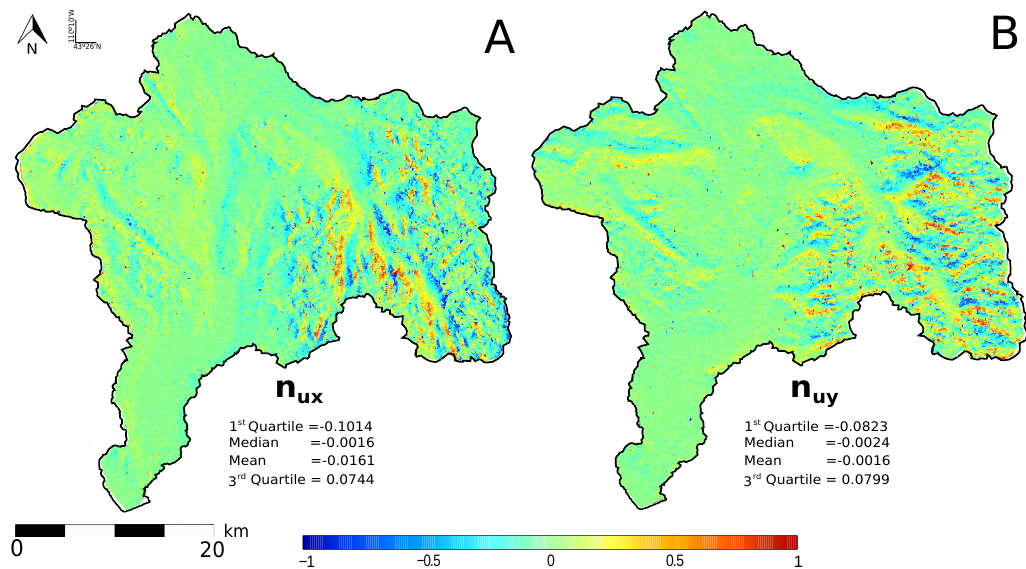
Figure 3. Spatial distribution and central tendency statistics of the ( A ) n ux west-east and; ( B ) n uy south-north components of (cid:126) n u . Dark blue colors represent west and south facing triangles while dark red depicts east and north facing elements in A and B,